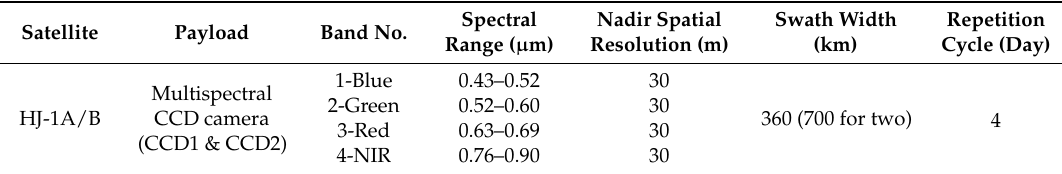
Table 2. Technical specification of HJ-1-A/B CCD